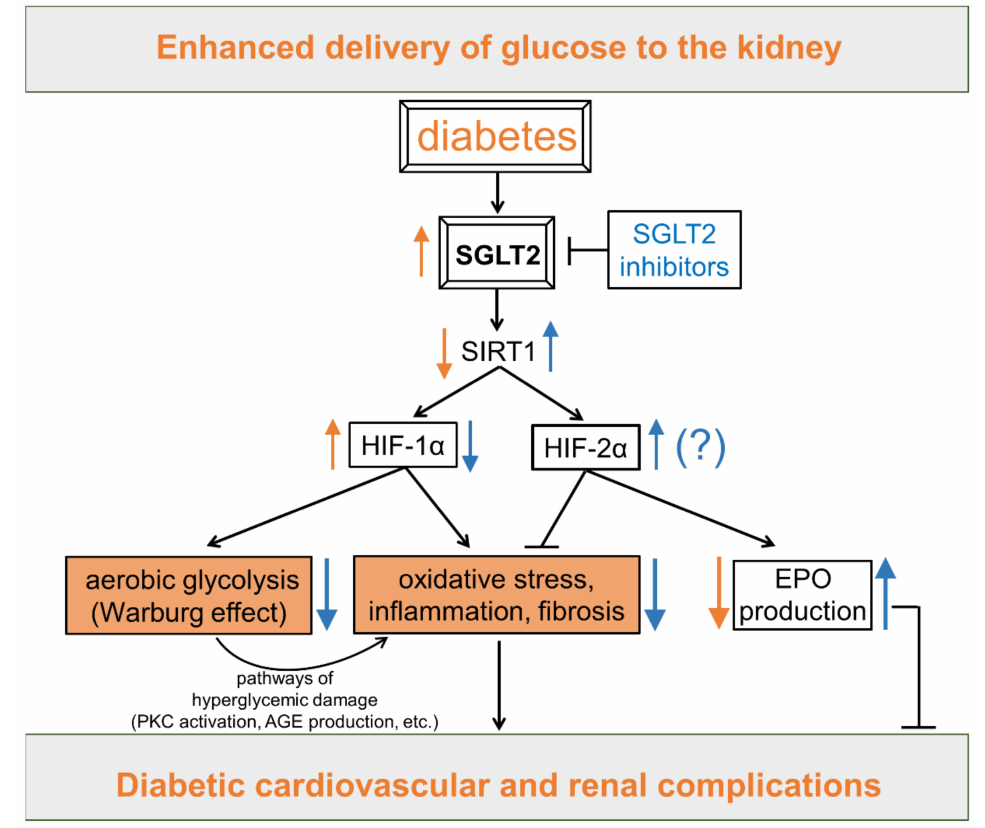
Figure 6. Potential cardioprotective and renoprotective effects of sodium glucose co-transporter 2 (SGLT2) inhibitors through modulation of sirtuin-1 (SIRT1) and the hypoxia-inducible factor (HIF) system. Refer to the main text for detailed description and references. Orange arrows/boxes are effects induced by diabetes. Blue arrows are effects induced by SGLT2 inhibitors. (?) = grounded on a solid rationale, but yet to be demonstrated; PKC = protein kinase C; AGE = advanced glycation end product; EPO =